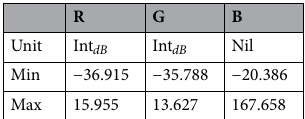
0 values in different bands.